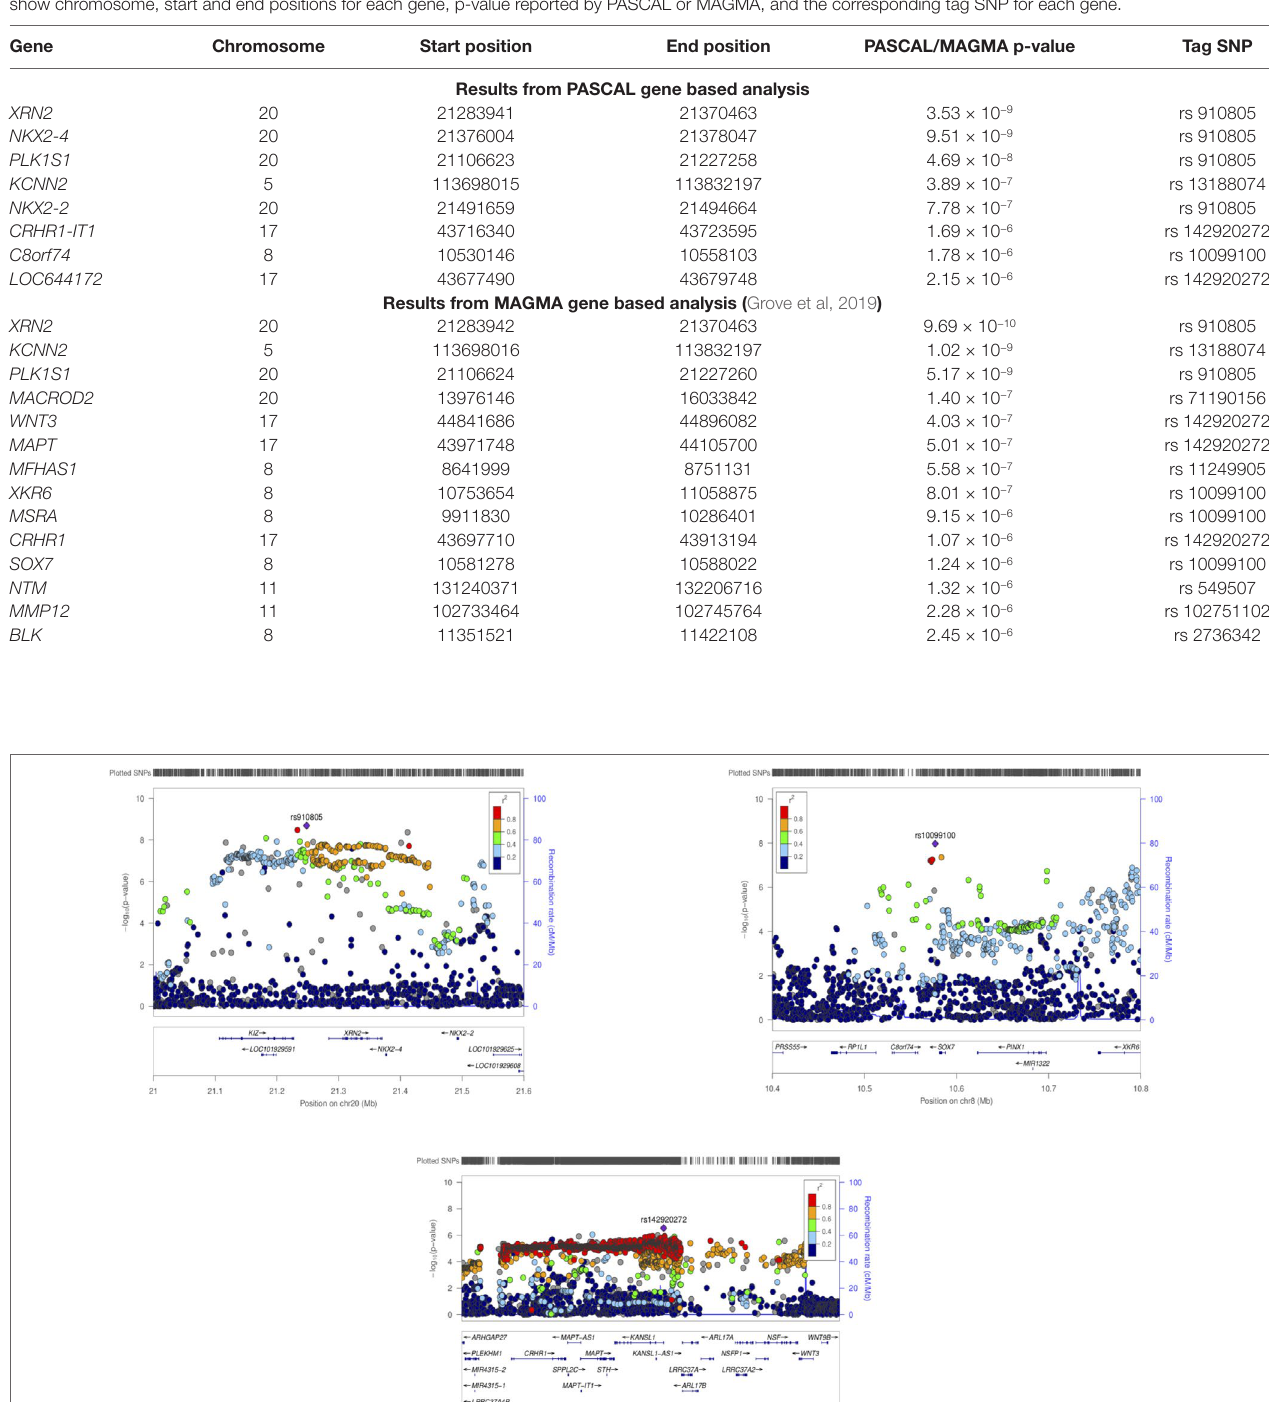
TABLE 4 | Significant genes reported by PASCAL and MAGMA algorithms. All significant genes reported in our study and Grove et al. publication are shown. Columns show chromosome, start and end positions for each gene, p-value reported by PASCAL or MAGMA, and the corresponding tag SNP for each gene.